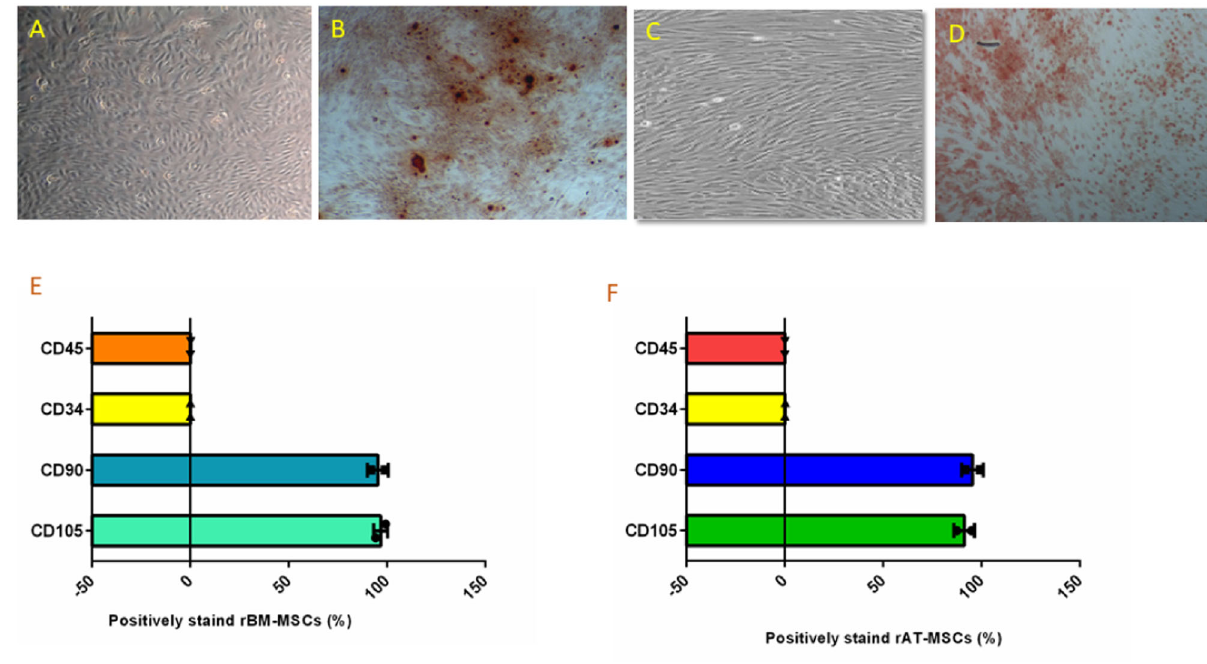
Fig. 3 Characterization of rat bone marrow MSCs (rBMSCs) and rat Adipose tissue stem cells (rATSCs). A The fi gure shows rBMSCs, their morphology is spindle shaped, and they established an adherent culture. B The fi gure shows rBMSCs after osteogenic differentiation and subsequently alizarin red staining, presence of red-stained mineralization particles con fi rmed the osteogenesis potential of them. C The fi gure shows rATSCs, they are a little longer or bigger than rBMSCs when compared under an inverted microscope. D The osteogenic induction of rATSCs was directed then the alizarin red staining was performed, presence of red-spots after alizarin red